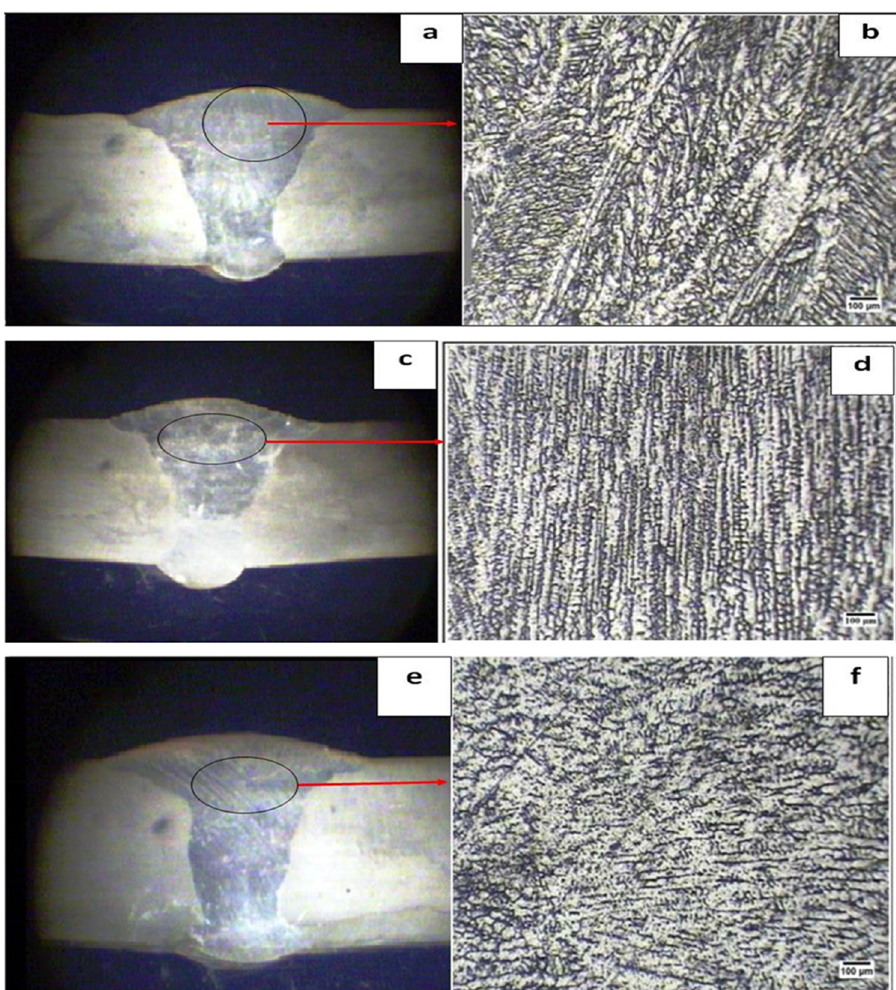
Fig. 6. (a) Macrograph of the conventional SMAW. (b) Microstructure analysis of conventional SMAW under no vibration condition. (c) Macrograph of the Vibratory SMAW. (d) Microstructure analysis of Vibratory SMAW under 150 Hz of frequency. (e) Macrograph of the Vibratory SMAW. (f) Microstructure analysis of Vibratory SMAW under 300 Hz of frequency. Stereo zoom (10 X) images showing the cross section of the weld pro fi le and photomicrograph (100 X) of Butt welded joint of the weld zone of the conventional and vibratory